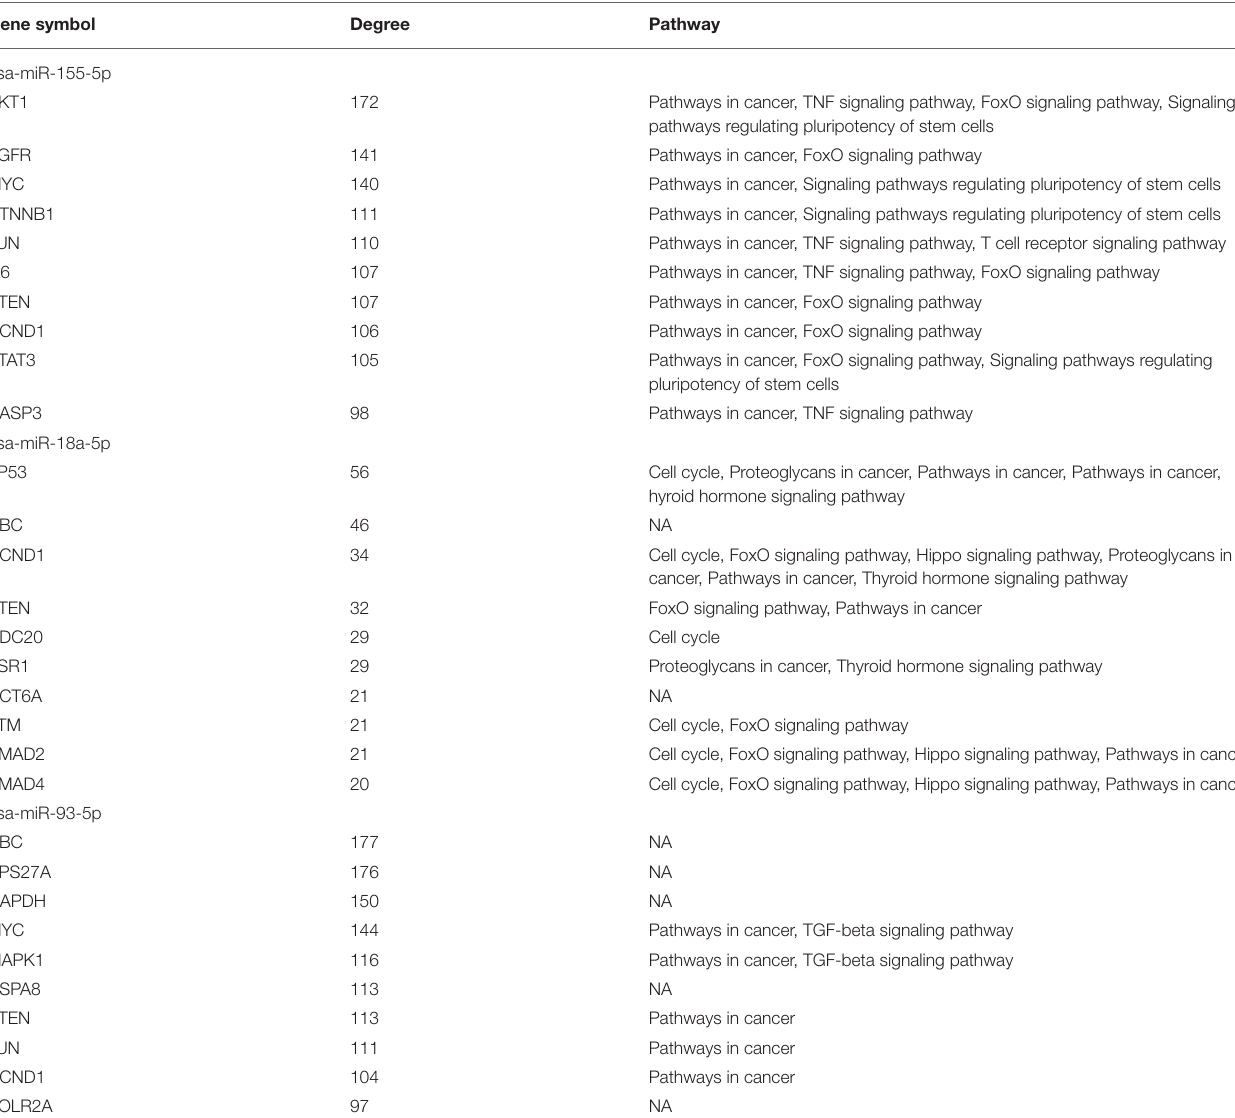
TABLE 1 | Hub genes identified in the PPI interaction. Gene